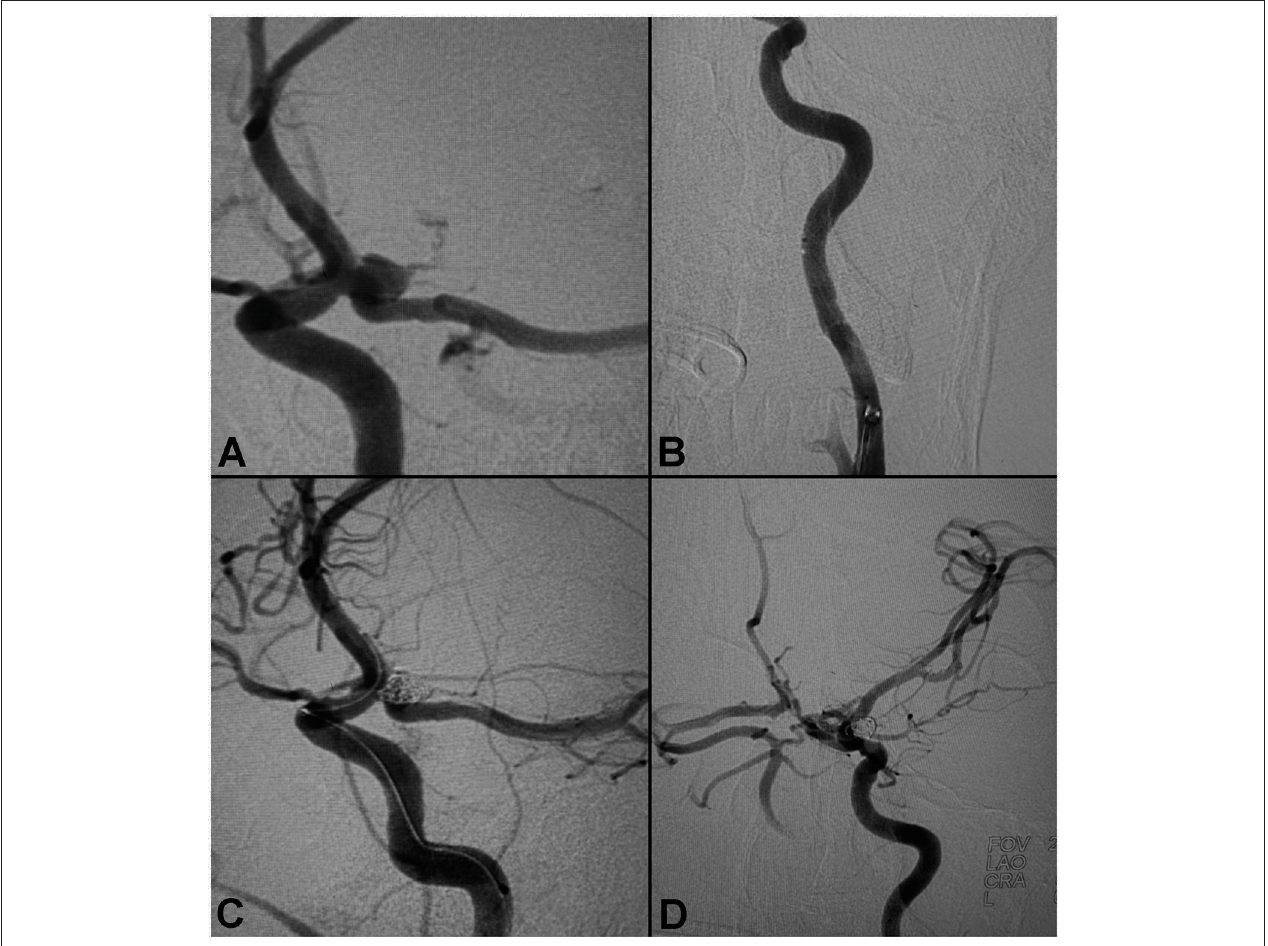
FIGURE 3 | Balloon-assisted coiling of a posterior communicating artery aneurysm. (A) Pre-procedure angiogram demonstrating a large PCA aneurysm. (B) Proximal anatomy. (C) Peri-coiling. (D) Post-coiling angiogram demonstrating no residual